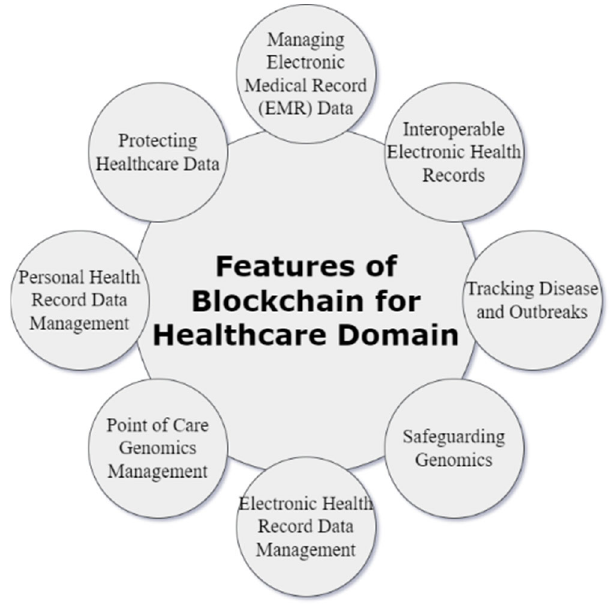
Figure 6. Blockchain features for the healthcare domain. Table 3. Issues addressed in the healthcare sector by blockchain ‐ based approach [159,160].